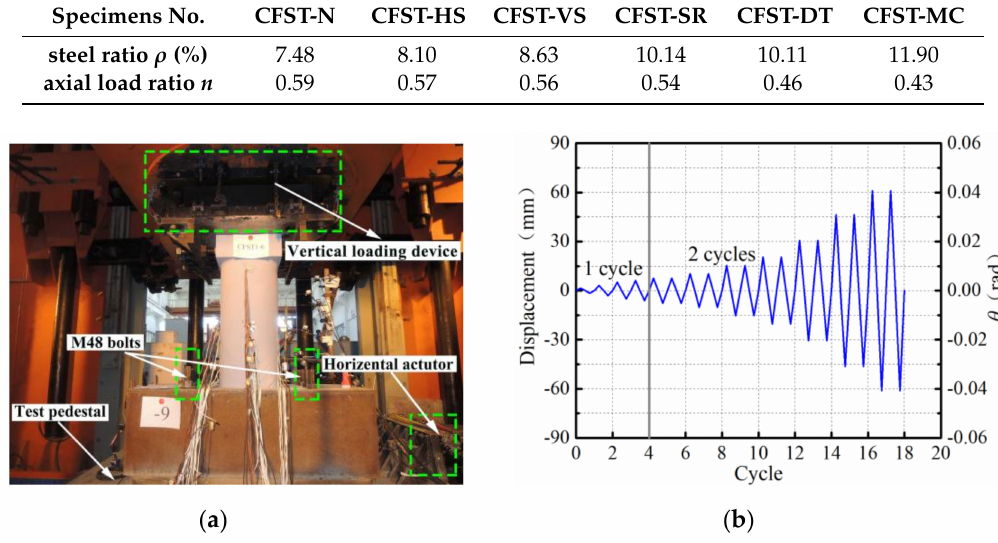
Table 3. Steel and axial load ratios.